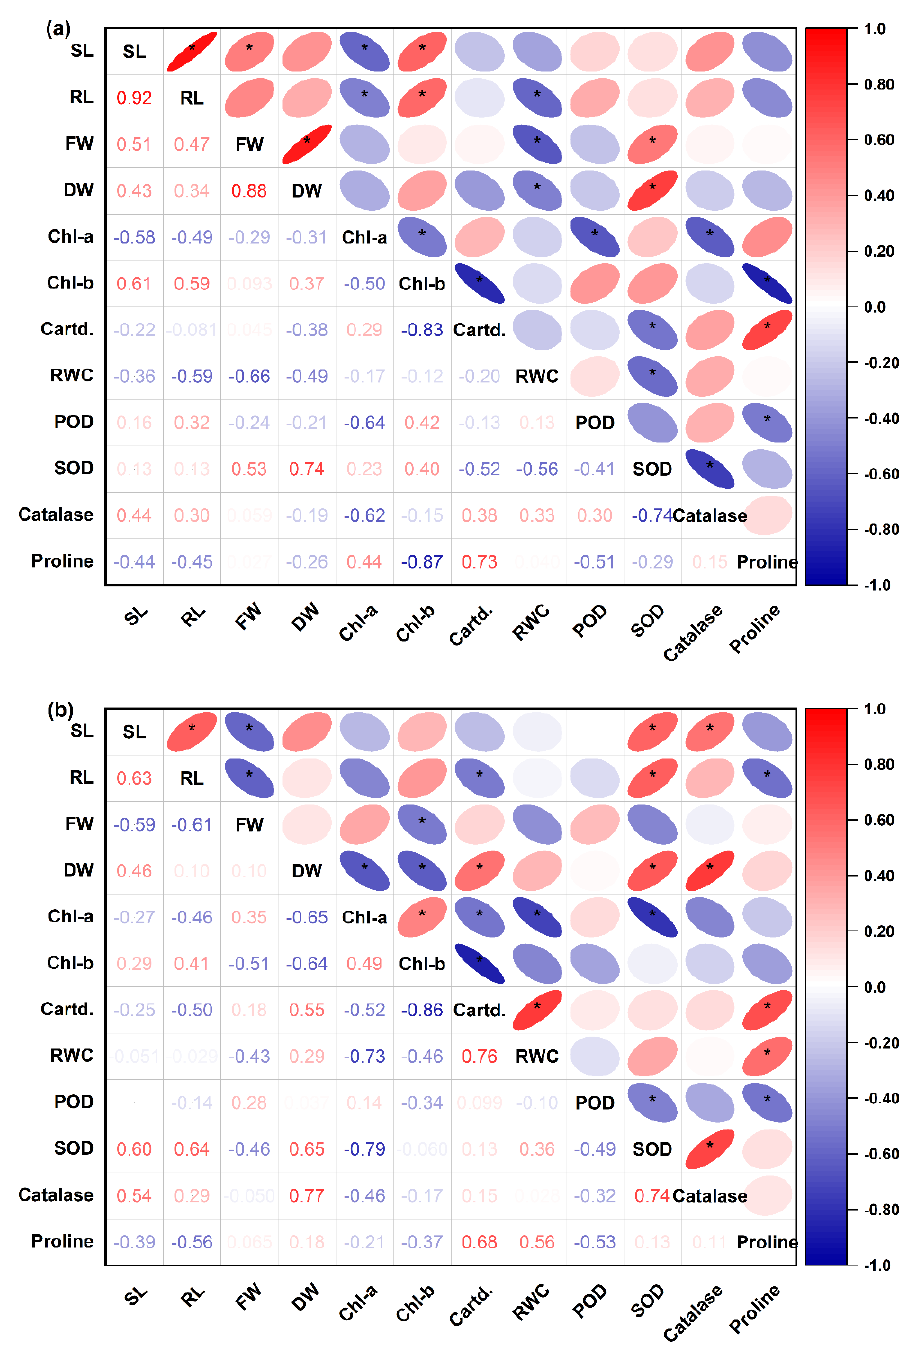
Figure 5. Pearson correlation analysis of inoculated strain (14asp) on growth and biochemical analysis of pea plants under two concentrations (75 mM and 150 mM NaCl). ( a ) Analysis of peas2009 and ( b ) correlation of 9800-10 variety. The red color shows the positive correlation among parameters and the blue color shows negative correlation.